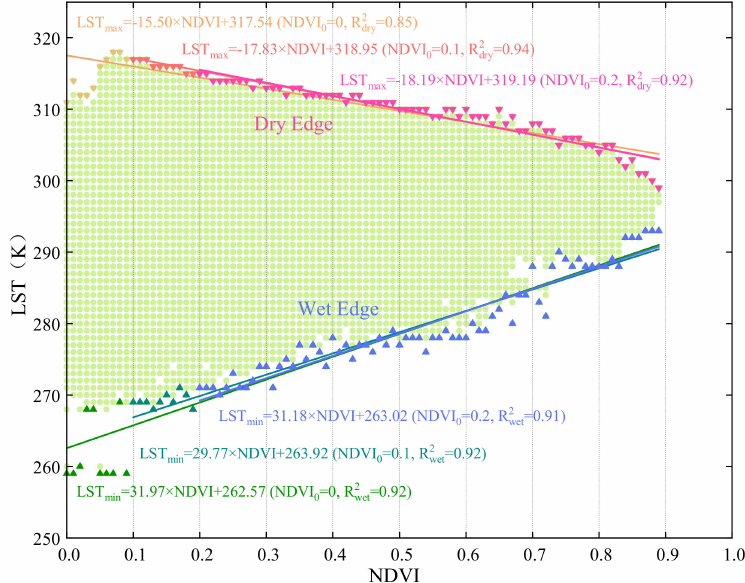
Figure 3. The dry and wet edges shown in the NDVI-LST triangular space formed by a scatterplot of NDVI against LST in 2017 (DOY 113) over the